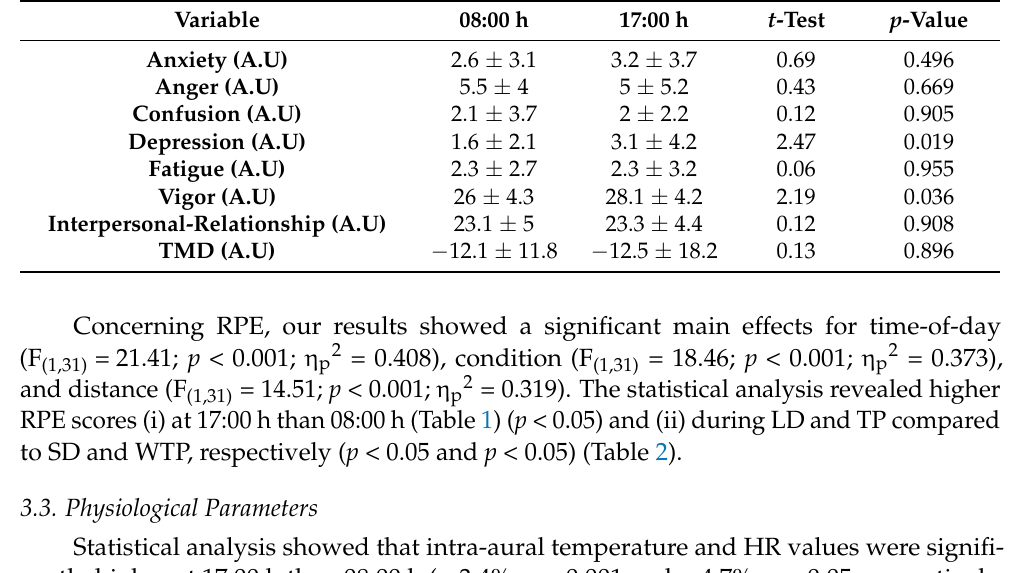
Table 2. The POMS subscale and TMD scores recorded at the two times of day.